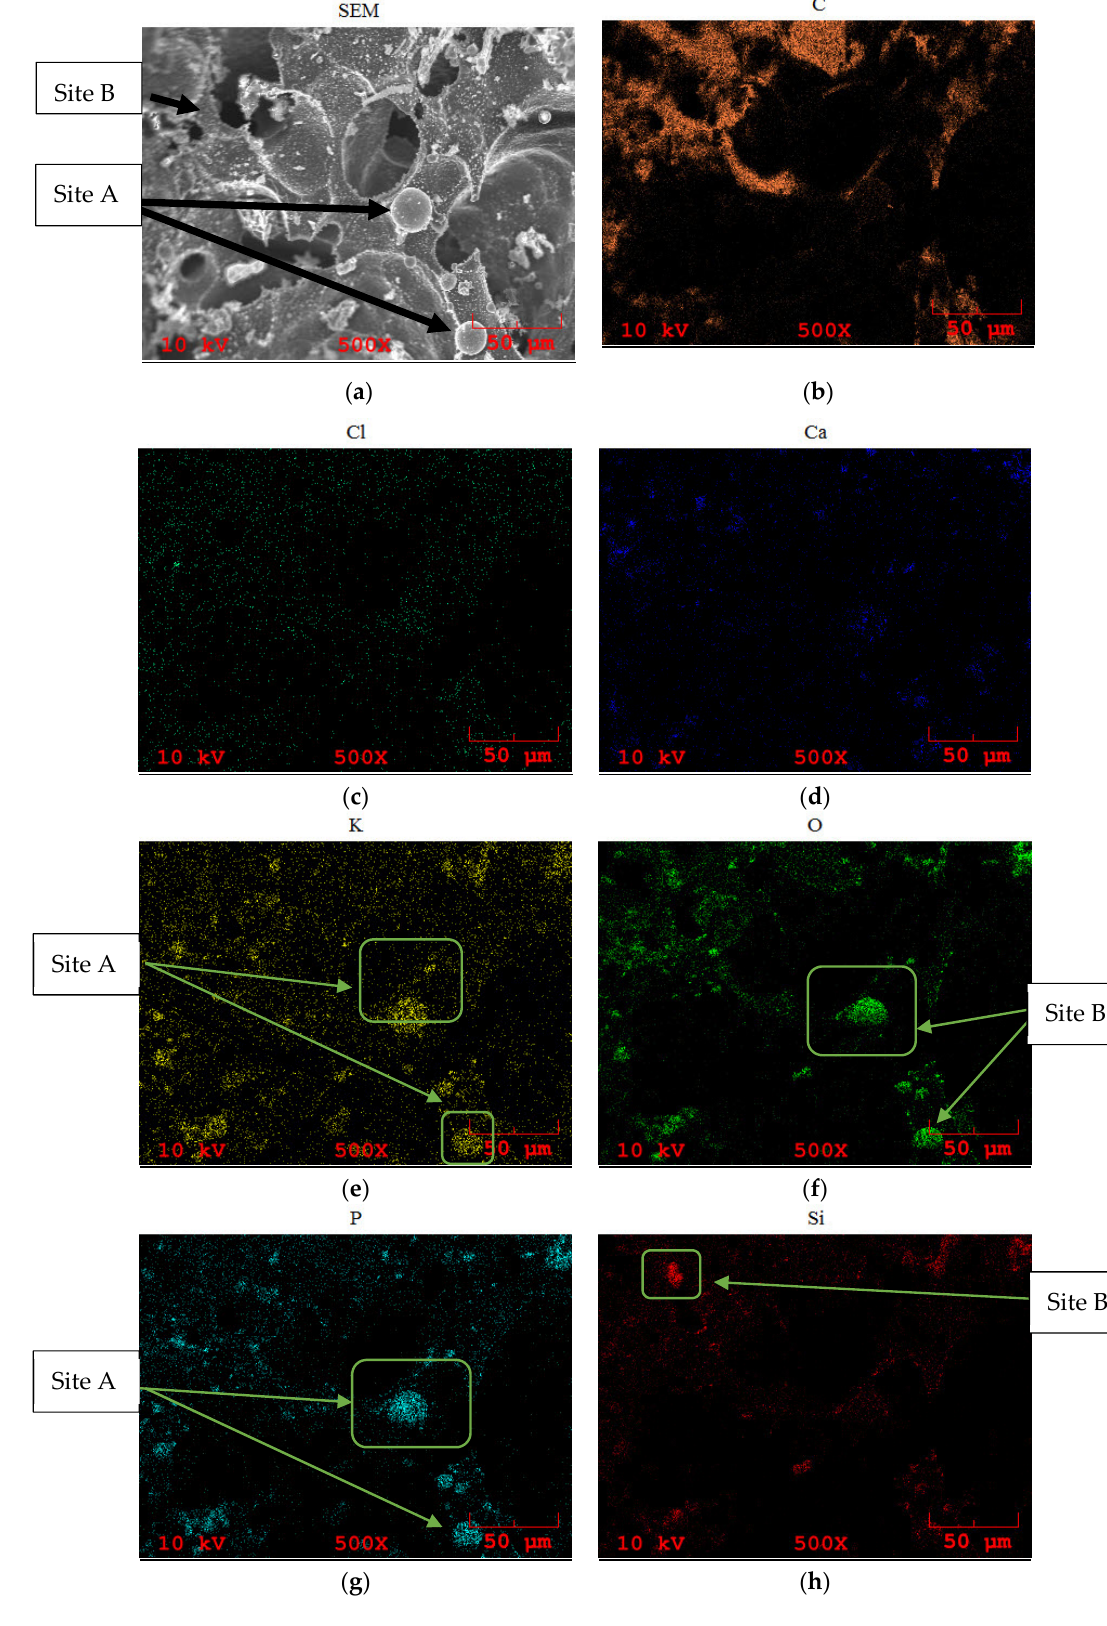
Figure 9. X-ray surface area analysis from outer soybean biochar—SEM Elements include ( a ) SEM surface image ( b ) carbon ( c ) Chlorine ( d ) Calcium ( e ) Potassium ( f ) Oxygen ( g ) Phosphorus ( h ) Silicon distribution on the surface.